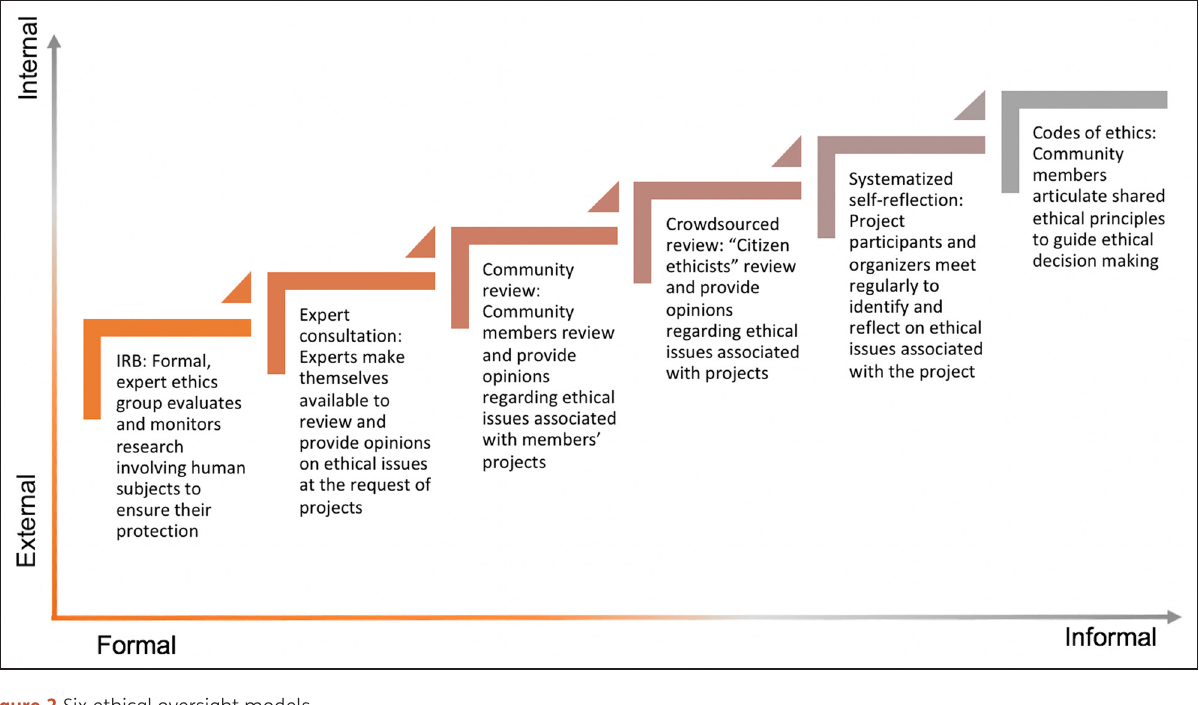
Figure 2 Six ethical oversight models.